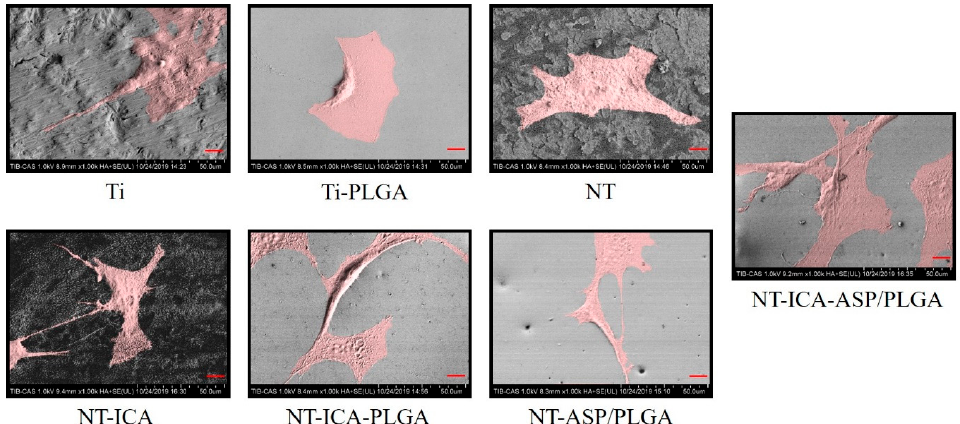
Figure 10. Images of MC3T3 − E1 cells showing the representative morphology on different substrates after 24 h of culture were obtained with scanning electron microscope (SEM, SU8010, Hitachi, Tokyo, Japan). The pseudo colored pink cells indicate morphology of MC3T3 − E1 cells; 1000 ×, scale bar = 10 μ m.